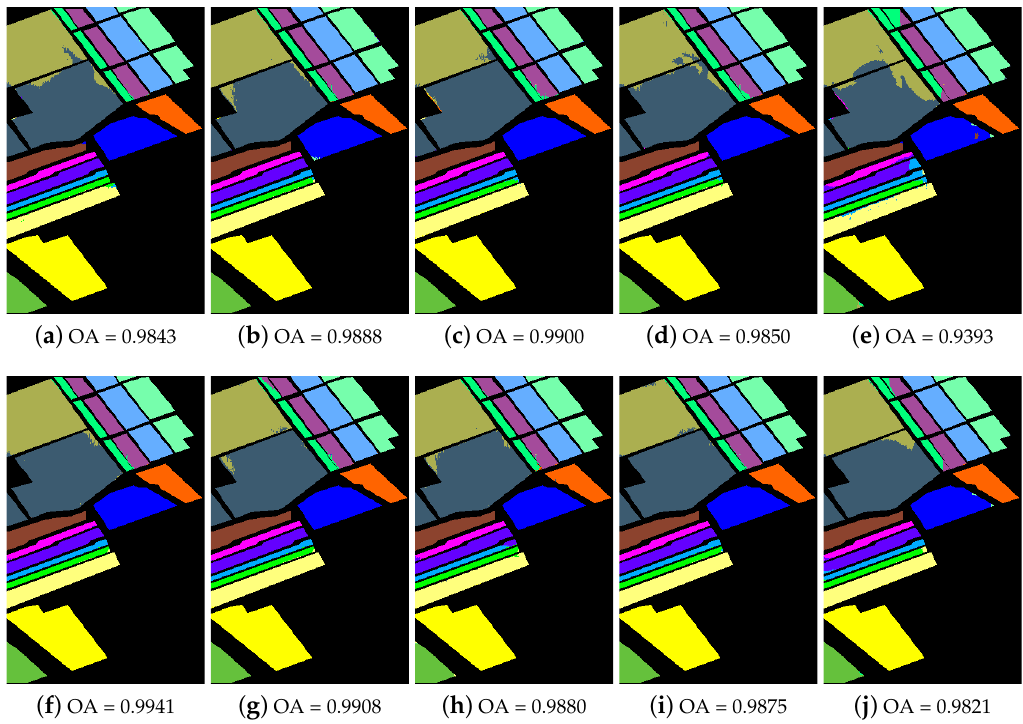
Figure 8. Supervised and semi-supervised classification results (Salinas image) obtained by: ( a )